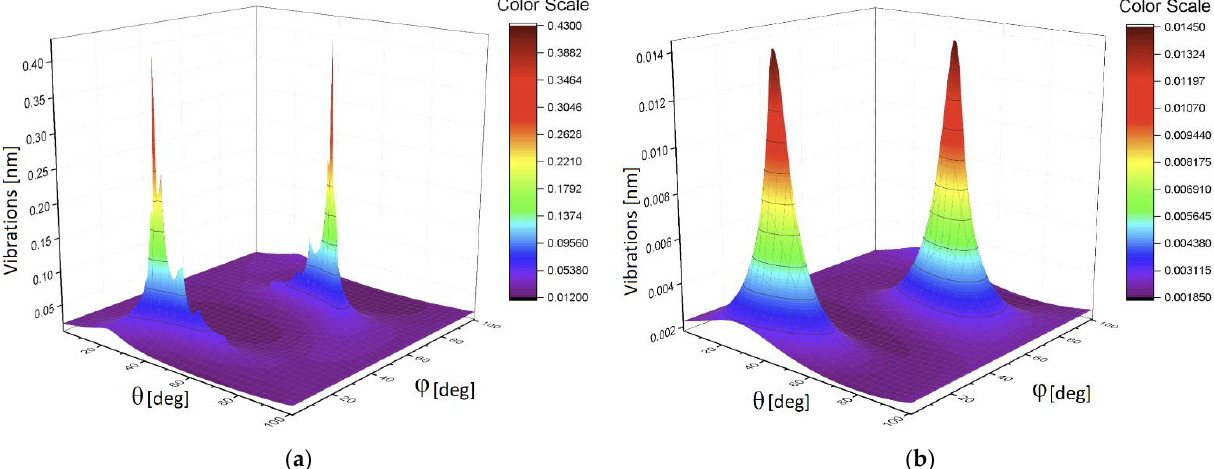
Figure 10. ( a ) The 3D surface for the L = 0 g; ( b ) the 3D surface for L = 50 g.